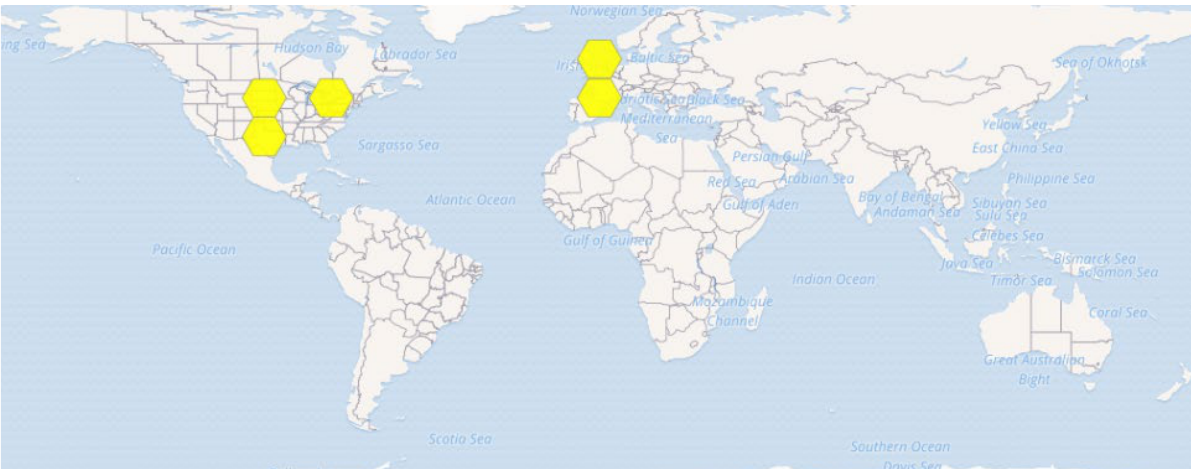
Fig. 2. Trichuris skrjabini worldwide geolocation record data on request on the platform of the GBIF information system ( Trichuris skrjabini Baskakov, 1924 in GBIF Secretariat, 2022)